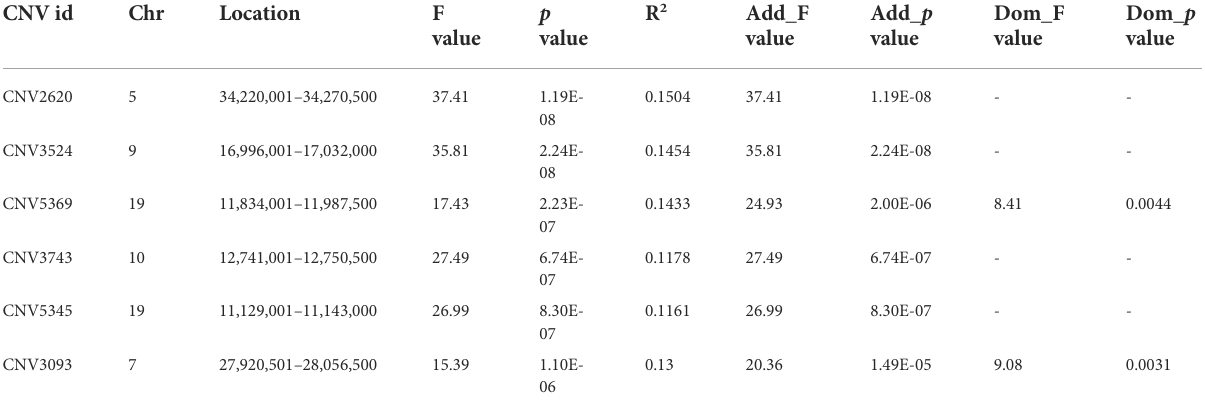
TABLE 4 Basic information of the CNVRs associated with the cervical vertebrae number in the Pekin duck